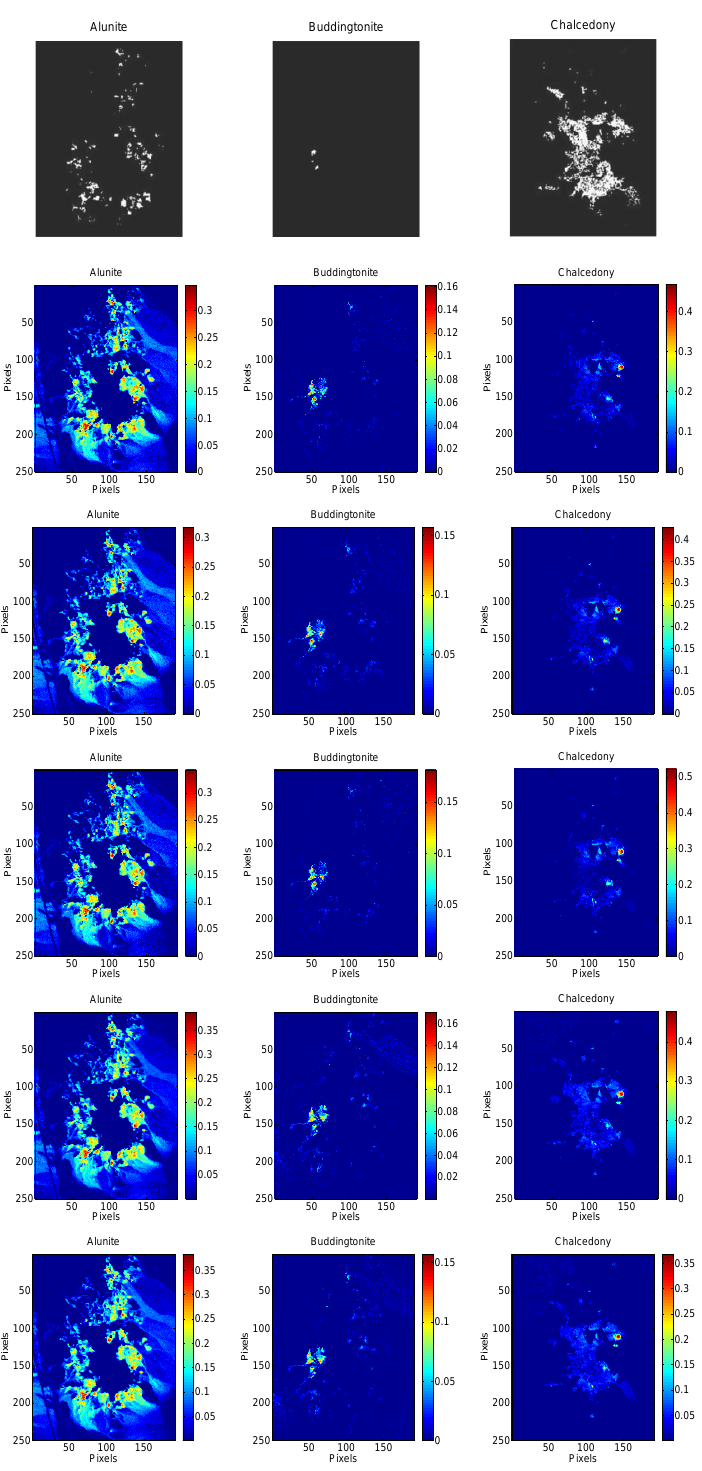
Figure 23. Fractional abundance maps of three representative endmembers estimated by different unmixing methods using Cuprite dataset having 250 × 191 pixels and 188 bands. From top to bottom: USGS Tetracorder classification map, SUnSAL ( λ = 10 − 3 ), CLSUnSAL ( λ = 10 − 1 ), CUSAL-SP ( λ = ˆ s × 10 − 3 ), SU-NLE ( d = 1) ( λ = 10 − 3 ) and SU-NLE ( d = 2) ( λ = 10 − 2